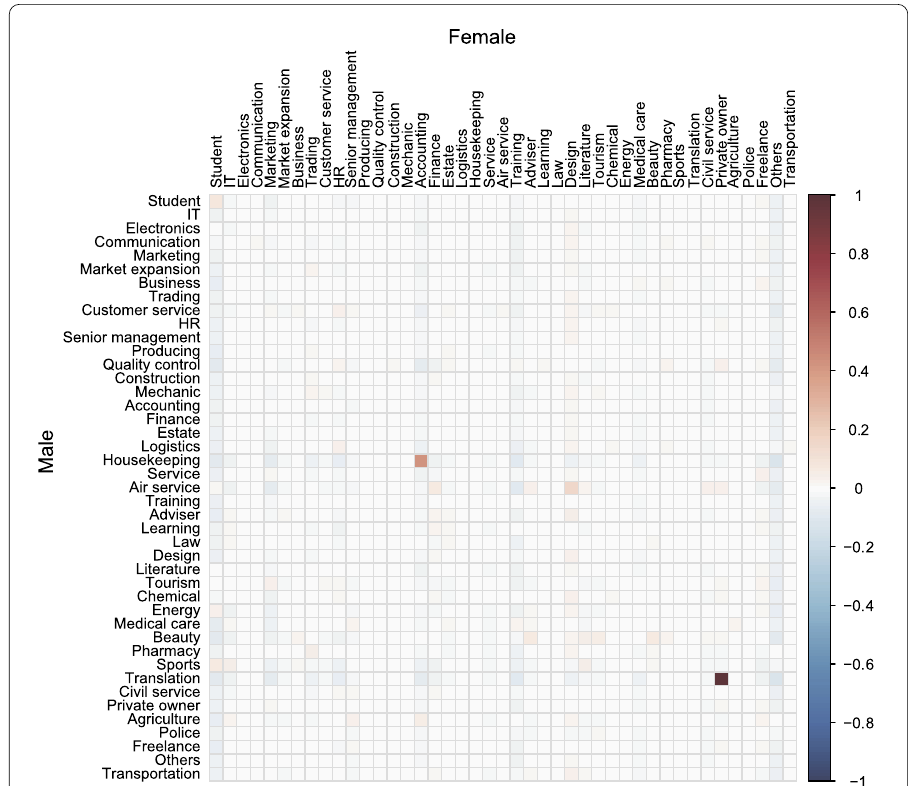
Figure 3 Employment preference for male users sending messages to female users. The vertical axis indicates the male occupations and the horizontal axis indicates the female occupations. Preference values are represented by different